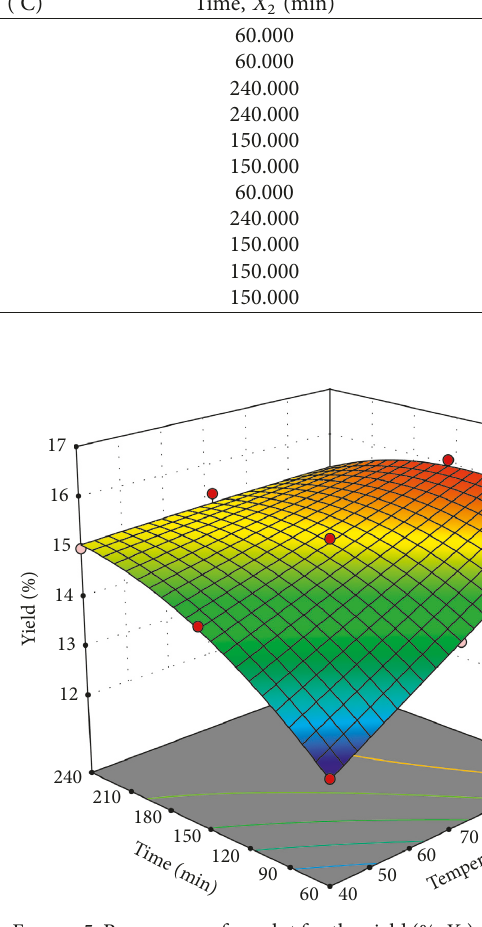
Figure 5: Response surface plot for the yield (%, Y 1 ) of the turmeric leaf extract at a constant value comparing extraction temperature ( ° C, X 1 ) and time (min, X 2 ). The optimum yield (%) of the turmeric leaf extract from CCD was 15.58 with the extract condition, 150min (time), 85 ° C (temperature), and 1:25